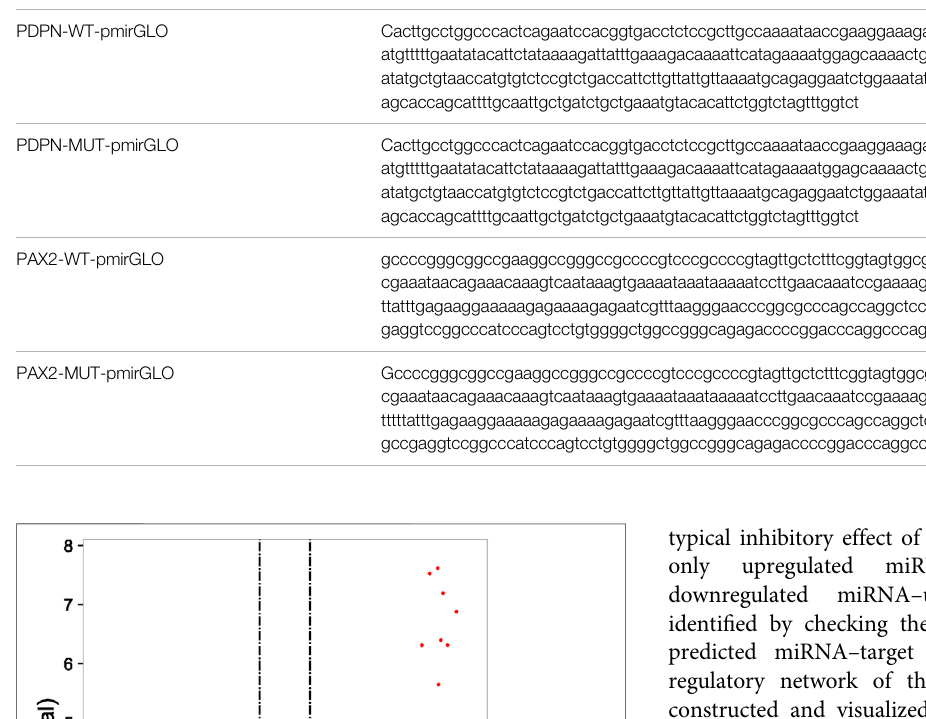
TABLE 2 | Dual-luciferase assay primer.